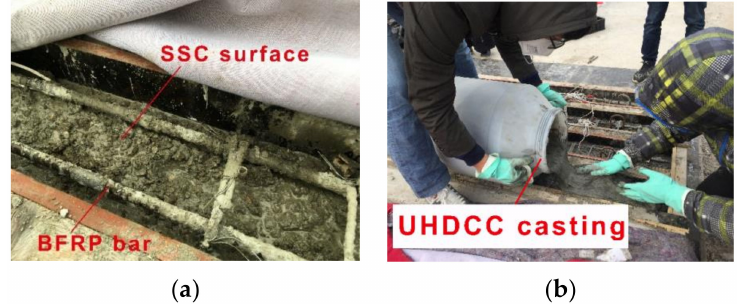
Figure 5. Casting of SCC-UHDCC beam: ( a ) casting of SSC layer; and ( b ) casting of UHDCC